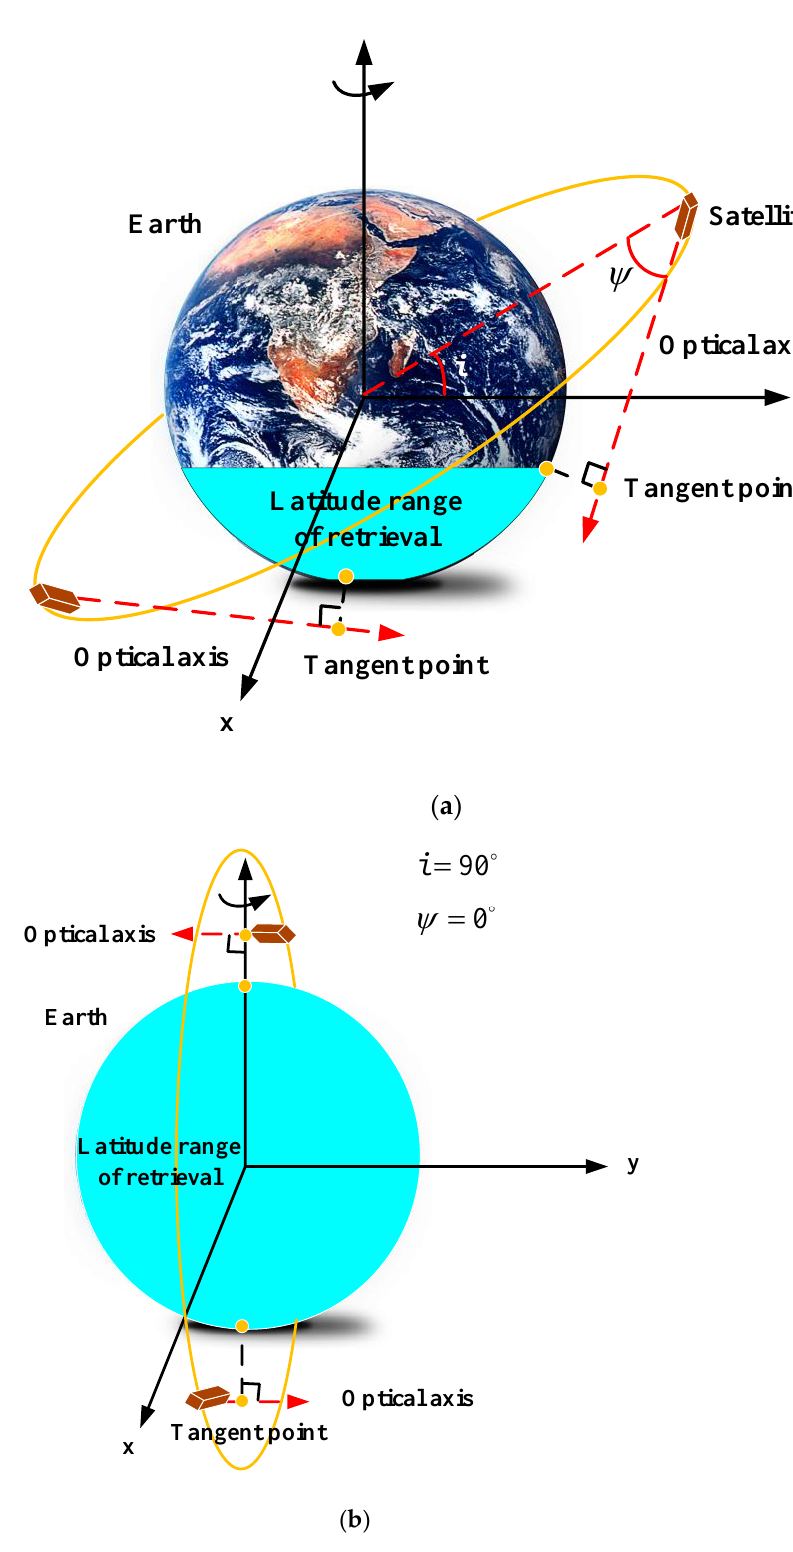
Figure 4. Schematic diagram of the latitude range of the retrieval. ( a ) Optical axis does not lie in the orbital plane and i < 90°. ( b ) Optical axis lies in the orbital plane and i = 90°.